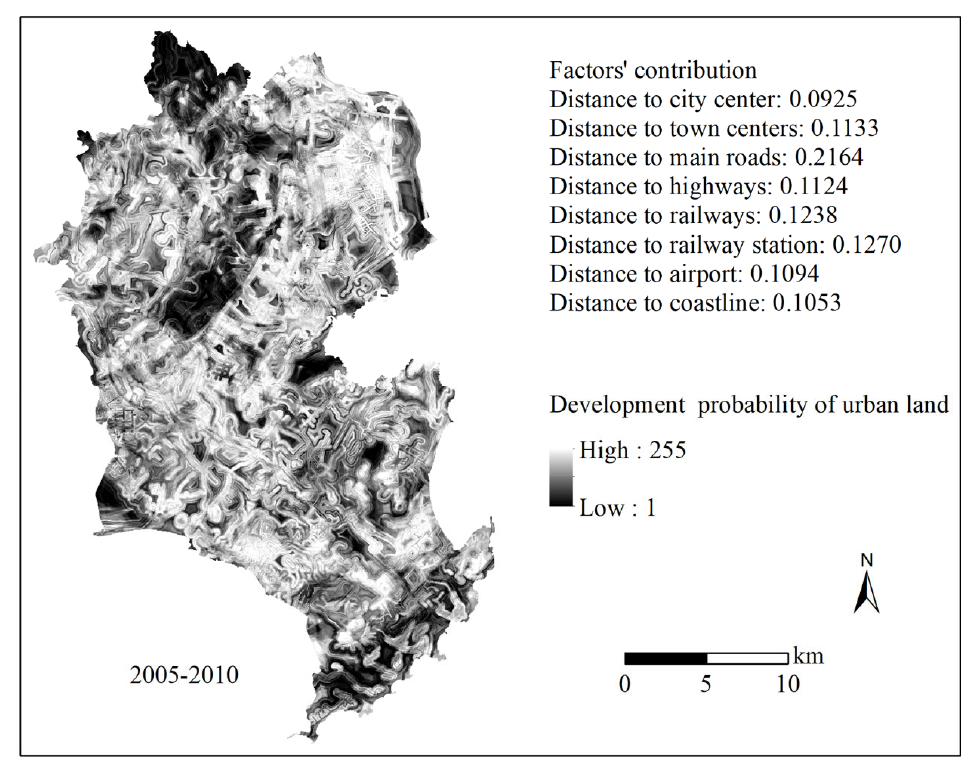
Figure 2. Suitability of urban land development mined by random forest algorithm in Jinjiang City from 2005 to 2010.